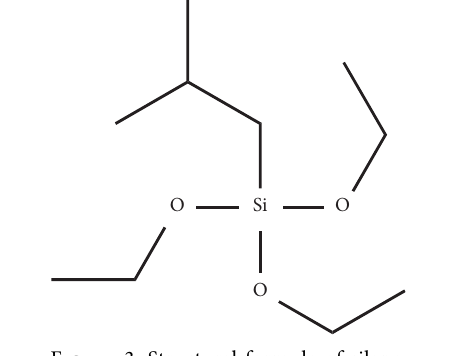
Figure 3: Structural formula of silane.